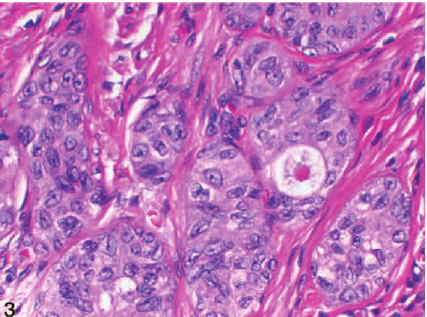
Figure 3: On high-power view, the tumour cells show no significant cytologic atypia (hematoxylin-eosin, original magnification × 400). Nested variant of urothelial carcinoma taken from Dhall et al. [2]. The figures have been reproduced with the permission of the editor in chief of Archives of Pathology and Laboratory Medicine on behalf of the editorial board of the